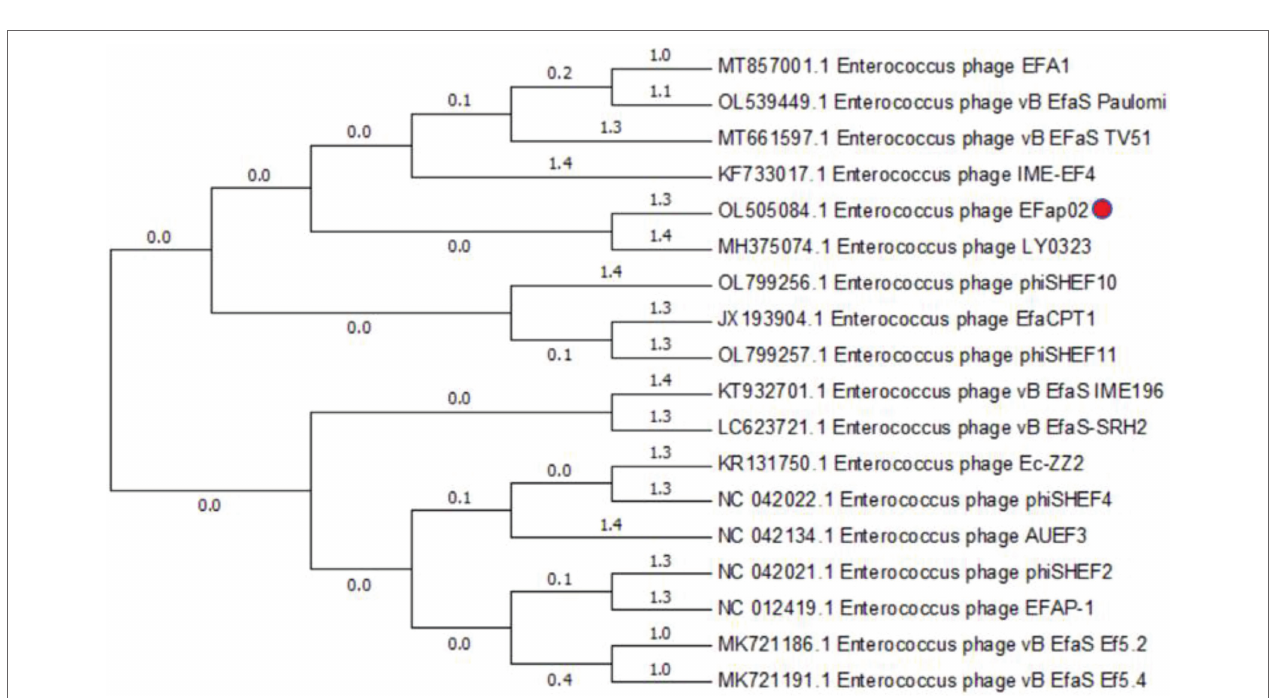
FIGURE 3 | Genome characterization of phage EFap02. Genome map of phage EFap02 and genetic characteristics. Circular genome visualization of EFap02 was performed using the CGView server database. Annotation of the specific function of ORFs was conducted using RAST and the BLASTP database. The first inner circle with the red histogram indicates the GC content, while the second inner circle with the purple and green histograms indicates the GC skew. The outer black circle indicates the predicted ORFs of phage